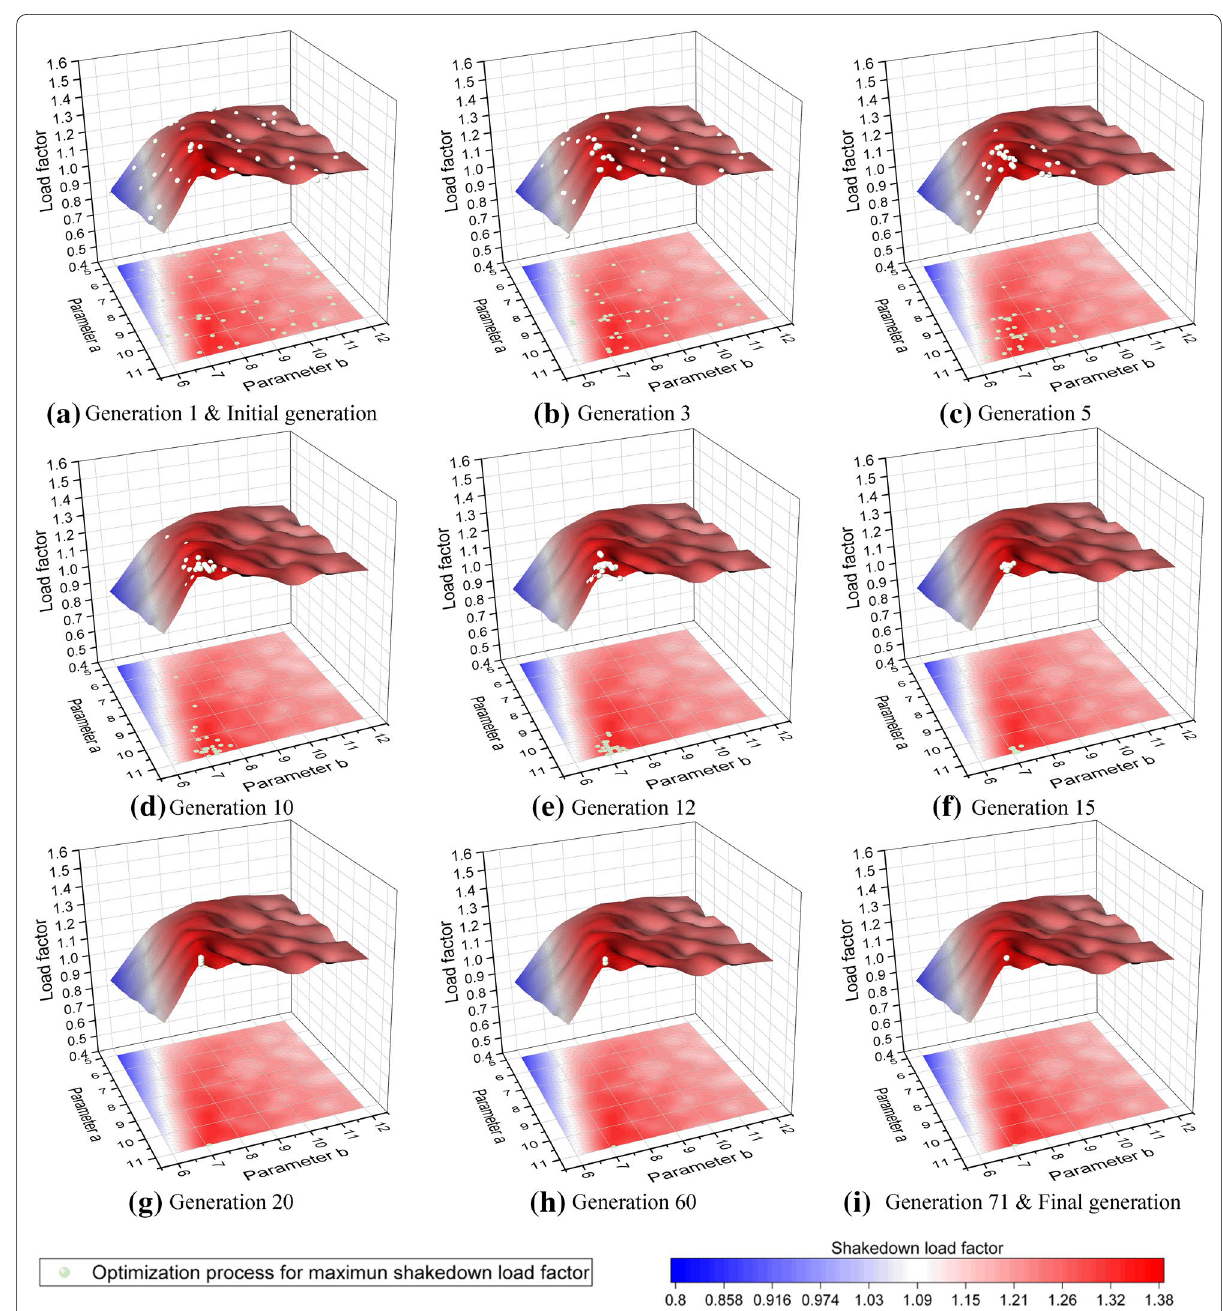
Figure 7 Population distribution in selected generations of optimization for maximum shakedown